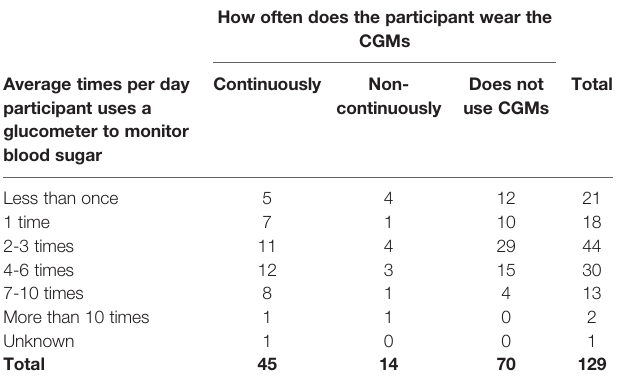
TABLE 8 | HI medication side effects. TABLE 9 | Frequency of glucometer and CGM